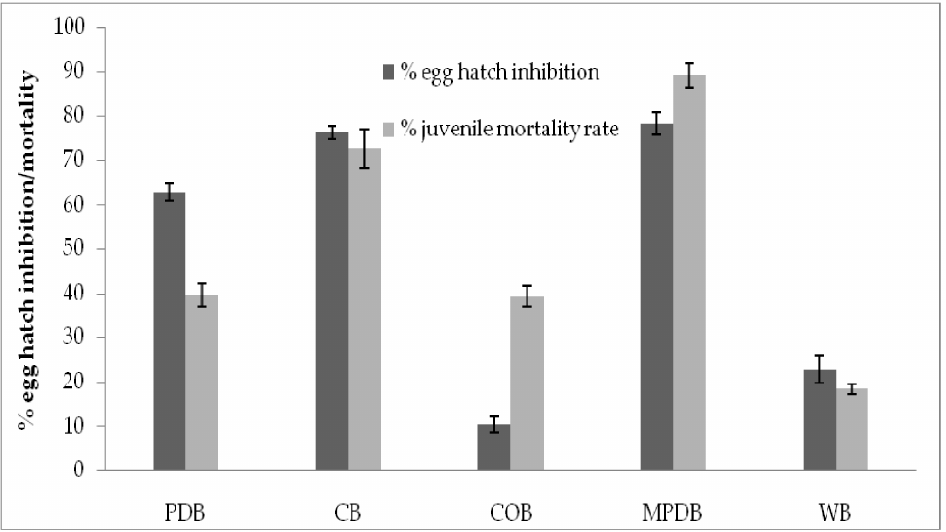
Figure 2. Effect of secondary metabolites from T. hamatum FB10 cultured in various culture media and nematicidal activity (PDB: Potato Dextrose broth; CB: Carrot broth; COB: Cornmeal broth; MPD: Modified Potato Dextrose broth; WB: Water broth).